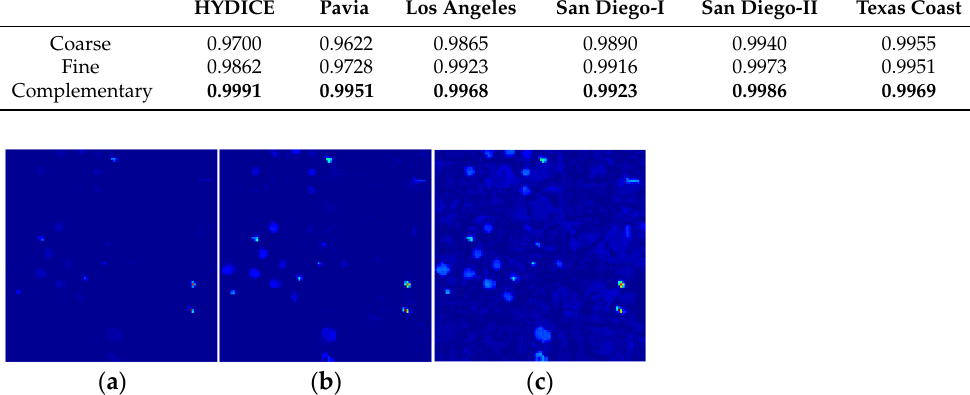
Figure 11. Visualization of detection map for the Los Angeles dataset on ( a ) dual dictionaries construction with only coarse binary map. ( b ) Dual dictionaries construction with only fine binary map. ( c ) Dual dictionaries construction with two-stage complementary decision.